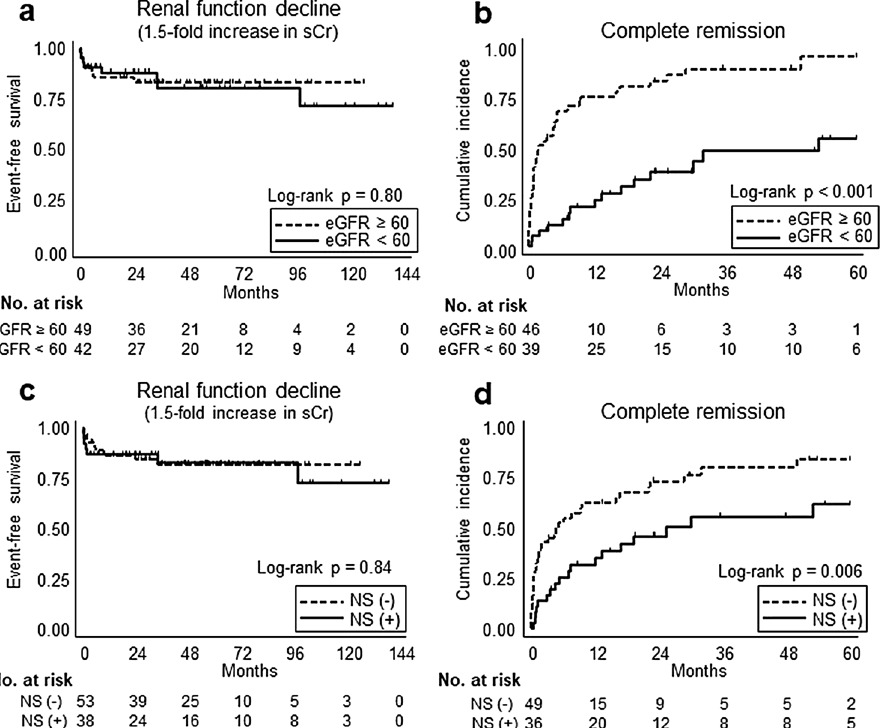
Figure 3. Survival curves of clinical outcomes. Kaplan–Meier plots are described according to the baseline eGFR levels ( a , b ), and with or without nephrotic syndrome ( c , d ). The cumulative incidence of renal event (1.5-fold increase in serum creatinine, sCr)-free survival is indicated on the y-axis ( a , c ), and that of complete remission is indicated on the y-axis ( b , d ). Duration (months) from the initiation of the induction therapy is indicated on x-axis. eGFR estimated glomerular filtration rate; NS nephrotic